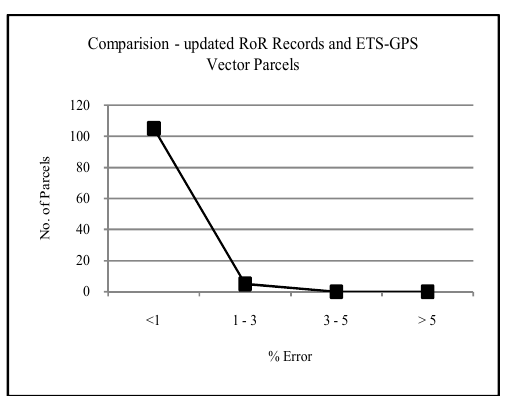
Figure 7. Plot of number of Parcels against the percentage error between updated RoR records and ETS-GPS Parcels GIS software environments and decimal truncations (Figure 7).